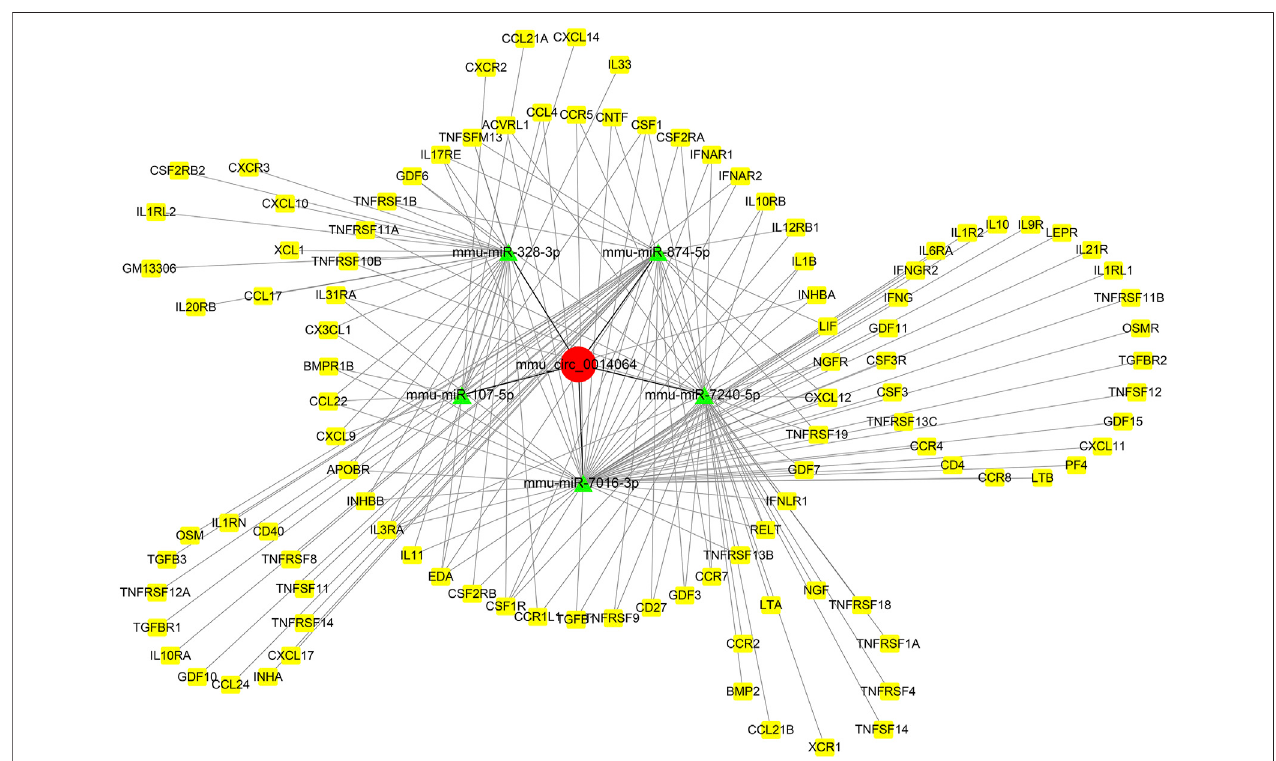
FIGURE 7 | The predicted mmu_circ_0014064-based regulatory network. Green nodes represent downregulated DE miRNAs, while the red and yellow nodes represent upregulated genes.